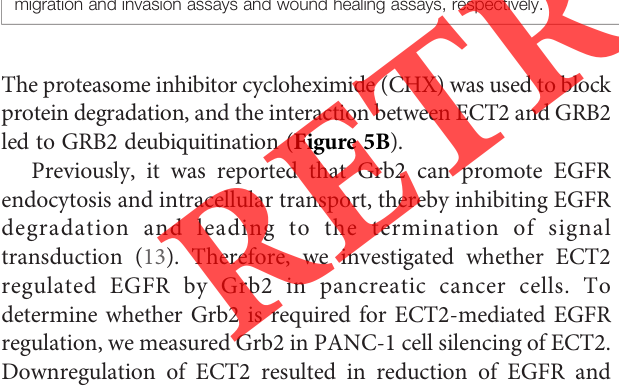
FIGURE 3 | Loss of ECT2 inhibits cell migration, invasion and EMT in vitro . (A) Representative pictures show the effect of epithelial cell transforming 2 (ECT2) shRNA treatment on cell migration and invasion. Scale bar: 100 m m. (B) Representative pictures show the effect of ECT2-Flag treatment on cell migration and invasion. Scale bar: 100 m m. (C) Representative images of wound healing assay show the effect of stable knockdown of ECT2 on HCC cell migration. (D) Phase contrast microphotographs of AsPC-1 cells infected with either shNC or ECT2-targeting shRNA. Scale bar: 100 m m. Three independent experiments were performed for cell migration and invasion assays and wound healing assays,